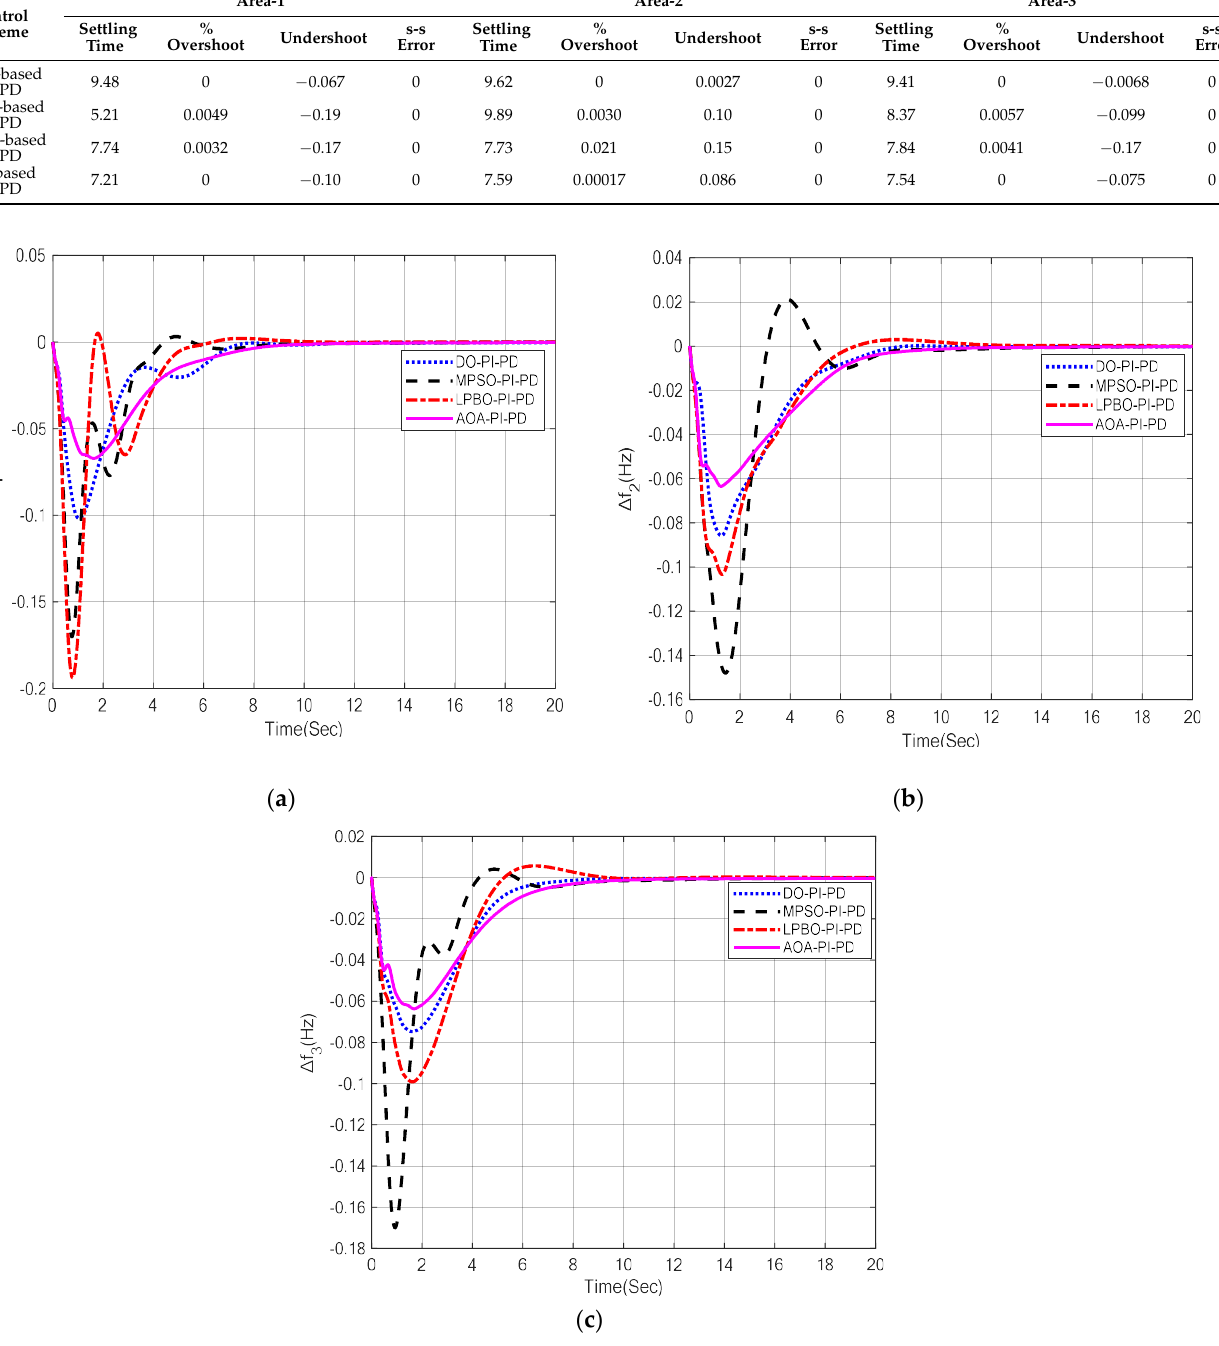
Figure 16. LFC responses in a three-area multi-source IPS with nonlinearities.( a ) ∆ f 1 ;( b ) ∆ f 2 ;( c ) ∆ f 3. Table 13. Numerical results of LFC in a three-area multi-source IPS with nonlinearities.